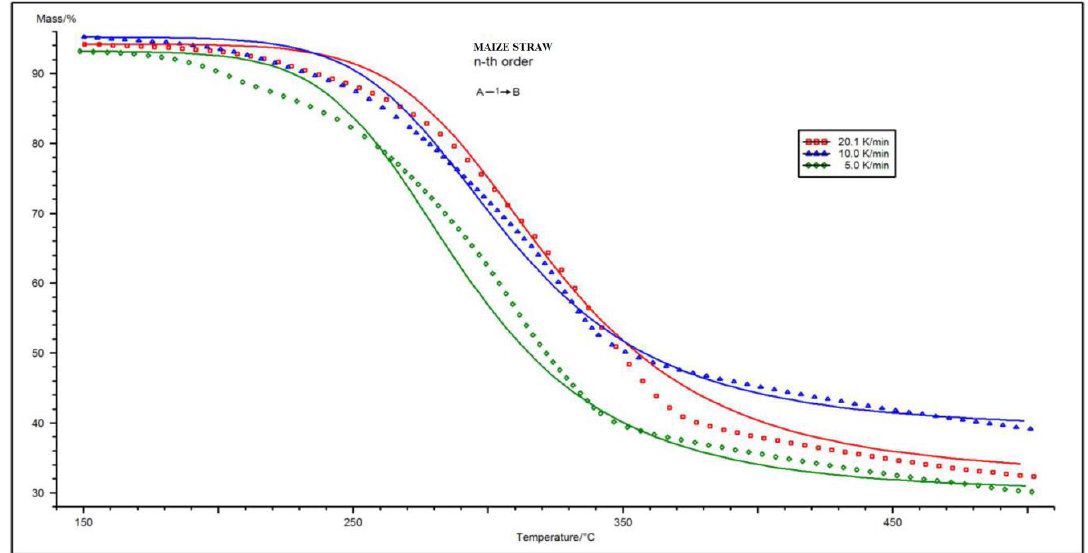
Figure 10. Fitting the calculated kinetic model to the experimental data for the maize straw sample.